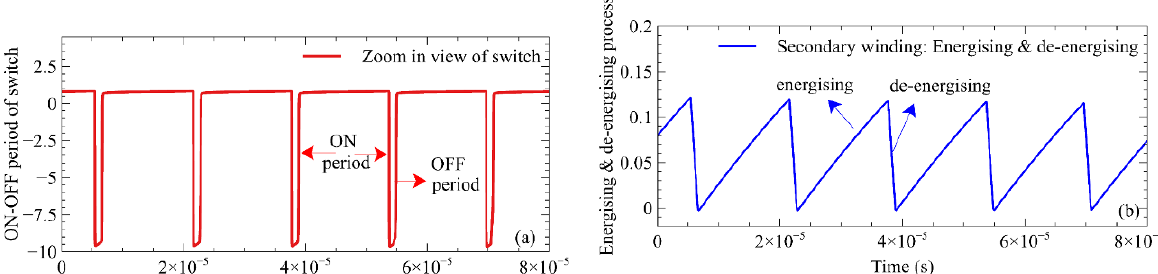
Figure 7. Energised windings (i.e., Modes 4 – 5): ( a ) Primary and ( b ) secondary.